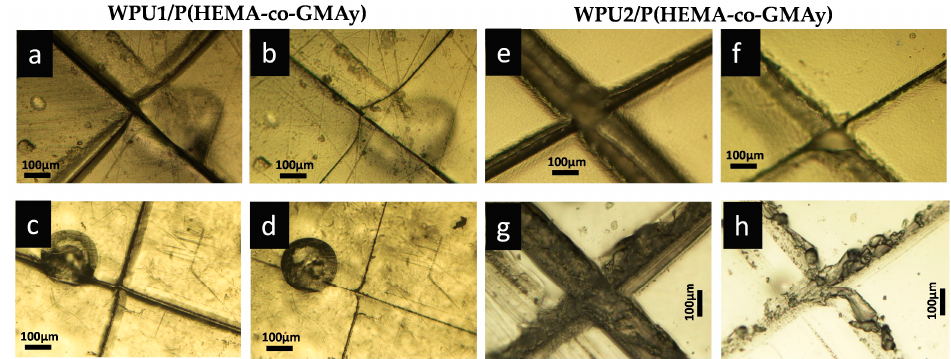
Figure 9. Optical microscopy photographs of ( a , b ) WPU1/10P(HEMA-co-GMA30); ( c , d ) WPU1/10P(HEMA-co-GMA50); ( e , f ) WPU2/10P(HEMA-co-GMA30); ( g , h ) WPU2/10P(HEMA-co-GMA50) specimens: images under damage ( a , c , e , g ) and healed ( b , d , f , h ) samples. Scale bars indicate 100 μ m.